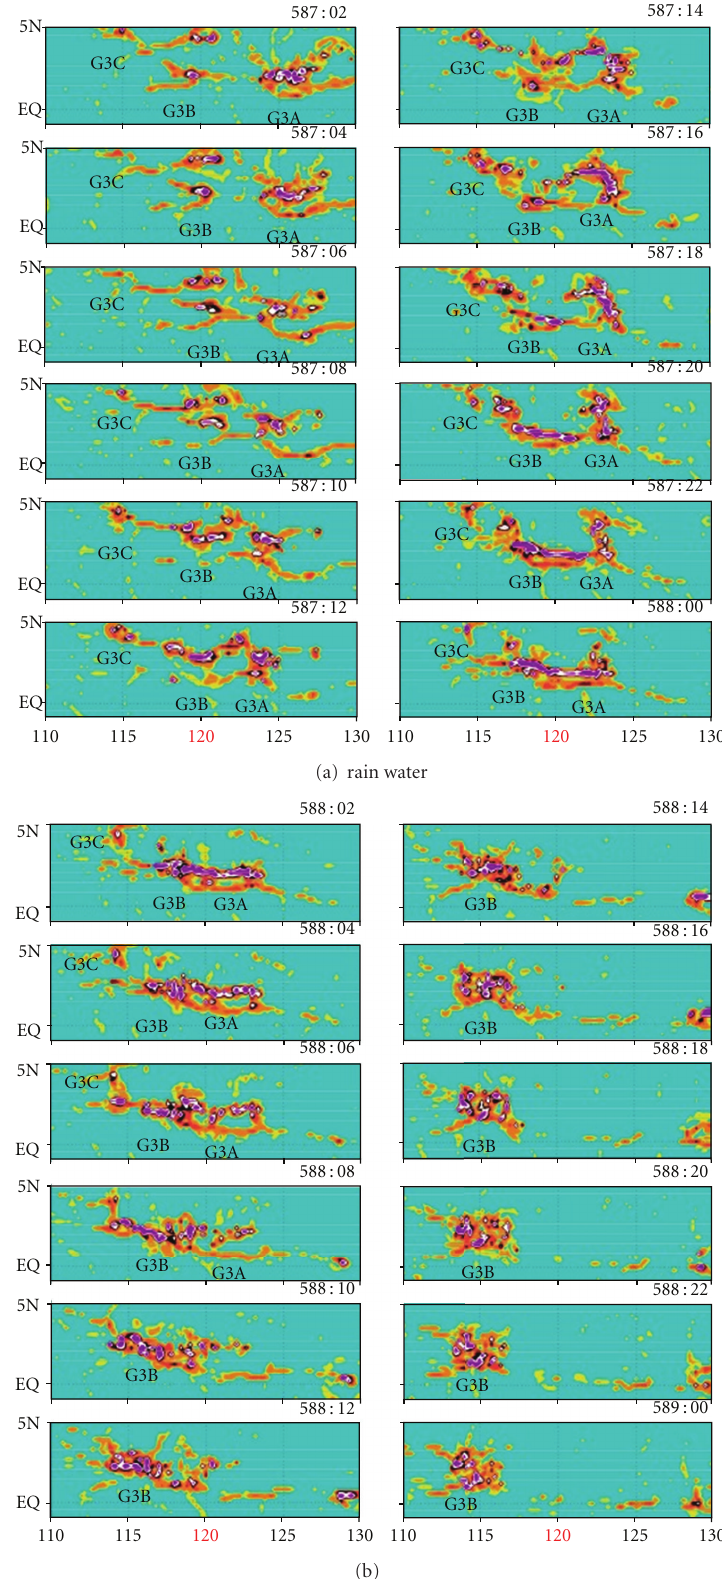
Figure 10: Horizontal distribution of the low-level rainwater mixing ratio in case (R) at a time interval of 2 hours; (a) from 587 day 02 hour to 588 day 00 hour, and (b) 588 day 02 hour–589 day 00 hour. Each of mesoscale convective systems, which constitute cloud cluster G3, is labeled by G3A, G3B, and G3C. The ordinate ranges from 1S to